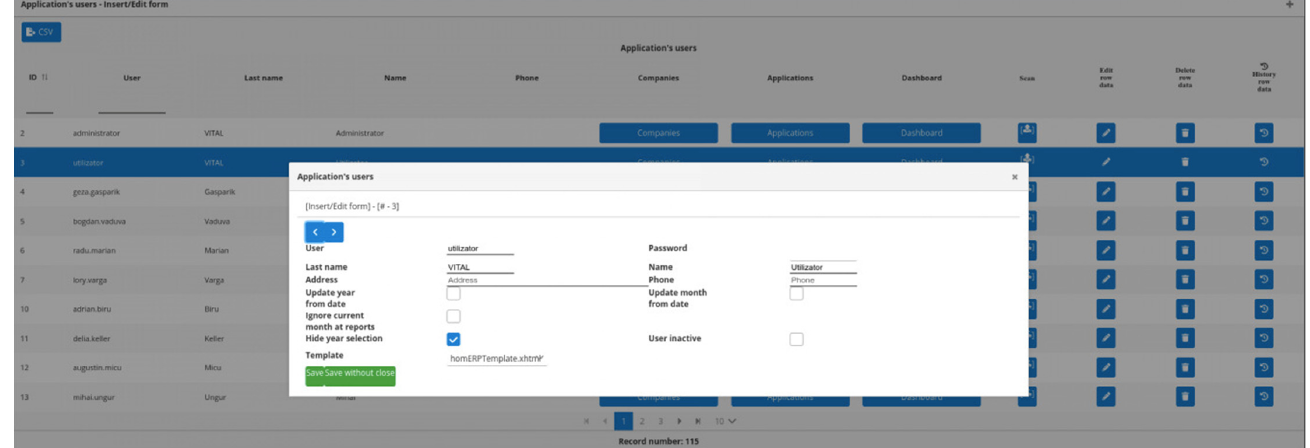
Figure 10. JavaScript/Angular 2+ “one4all” framework example—edit view.